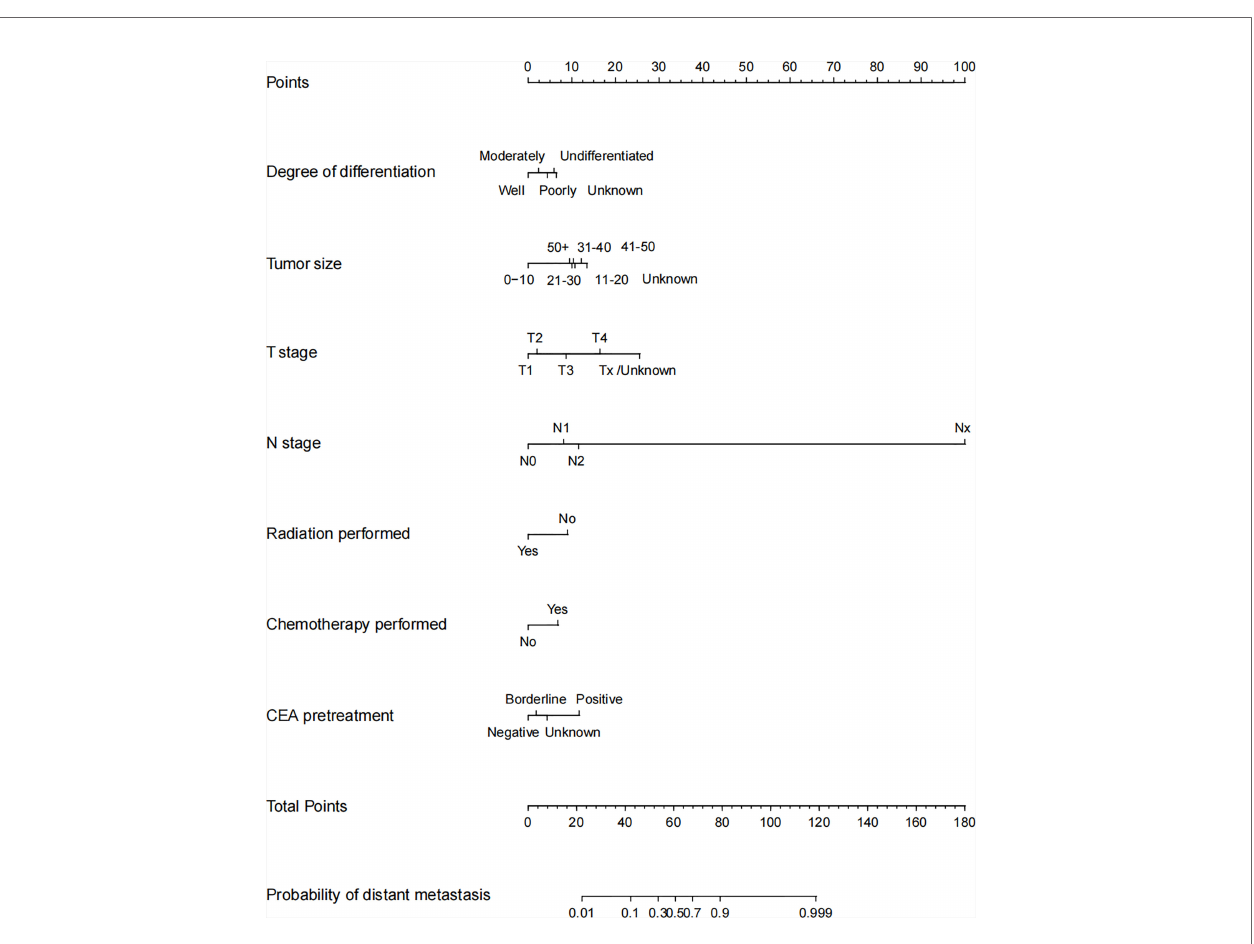
FIGURE 3 | Nomogram for distant metastasis of advanced stage young-onset colorectal cancer patients in training set. To estimate the risk of distant metastasis, the point of each variable was calculated by drawing a straight line from the patient variable value to the axis marked “ points. ” The total points are converted to the “ probability of distant metastasis ” on the lowest